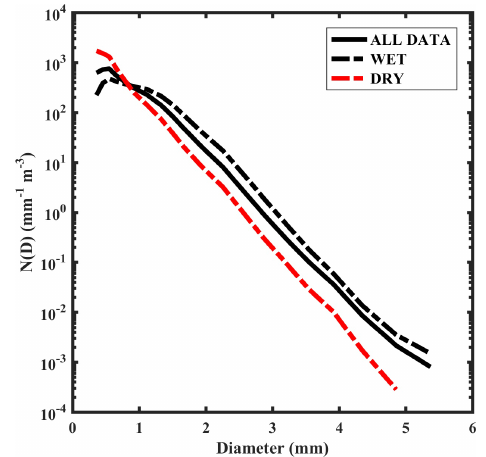
Figure 6. Average DSDs during wet and dry